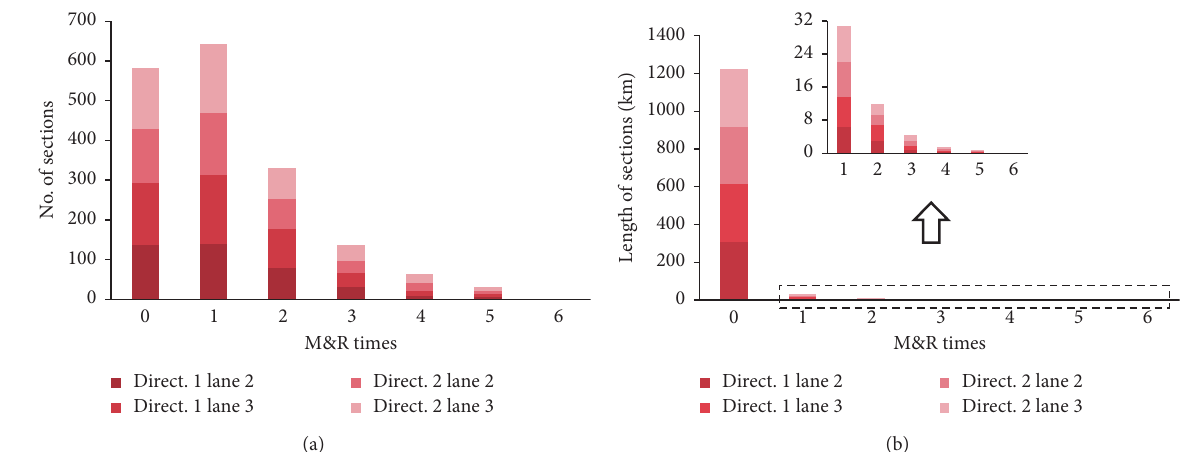
Figure 1: The amount and overall length of sections with or without M&R. (a) Counts. (b) Table 2: The utilized material indicators. Top layer Middle layer Bottom layer Dynamic stability (DS) Dynamic stability (DS) NA Retained Marshall stability (MS 0 ) Retained Marshall stability (MS 0 ) Tensile strength ratio (TSR) Tensile strength ratio (TSR) Failure strain ( − 10 ° C) Note. NA represents no data.